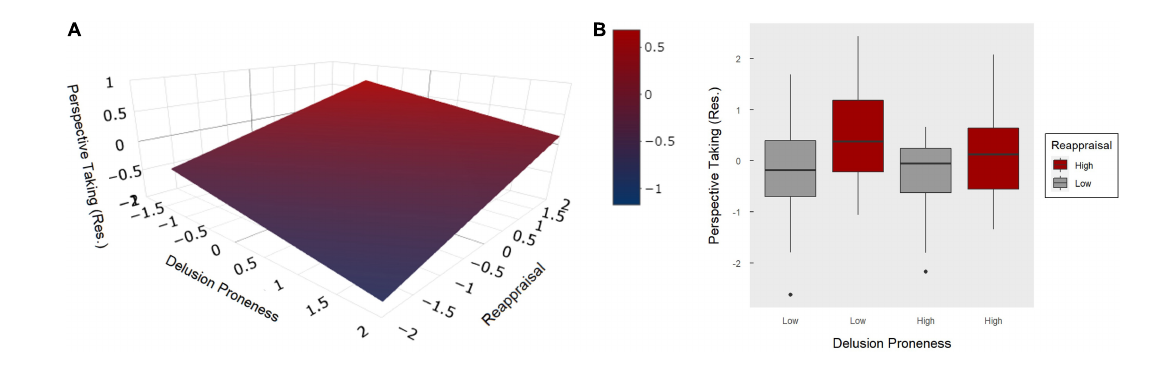
FIGURE1 Model 1: Main effects of reappraisal and delusion-proneness on perspective taking. (A) Graph illustrating the effects of reappraisal and delusion-proneness (both z-scored) as a linear combination predicting perspective taking. Perspective taking was residualized to remove the variance explained by covariates of non-interest (i.e., age, sex, race, intelligence, anxiety, and depression). (B) Boxplot of the median split for delusion-proneness and reappraisal demonstrating no interaction between these two predictors on perspective taking